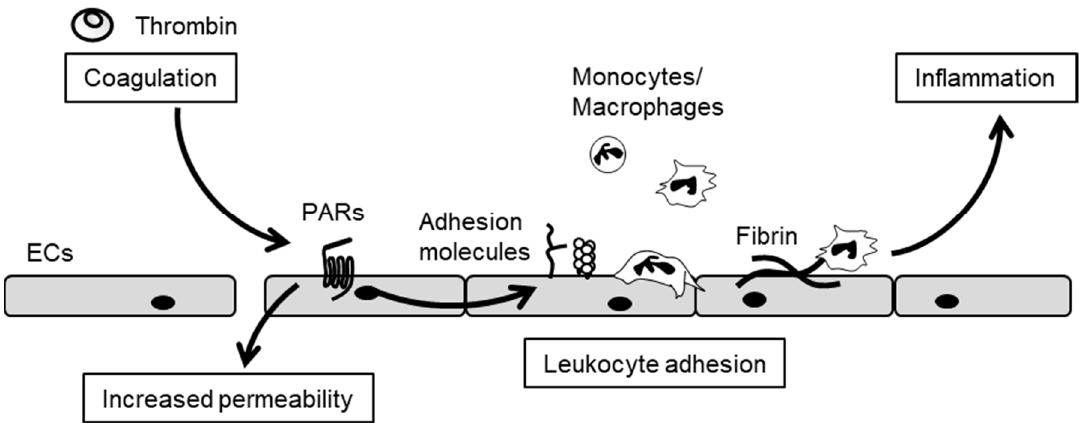
Figure 3. Thrombin induces the inflammatory responses of ECs. Thrombin activates protease-activated receptors (PARs), which induce the disruption of cell–cell junctions and the expression of adhesion molecules, cytokines and chemokines. Thus, the thrombin–PAR pathway contributes to the regulation of vascular permeability, leukocyte adhesion and vascular inflammation.